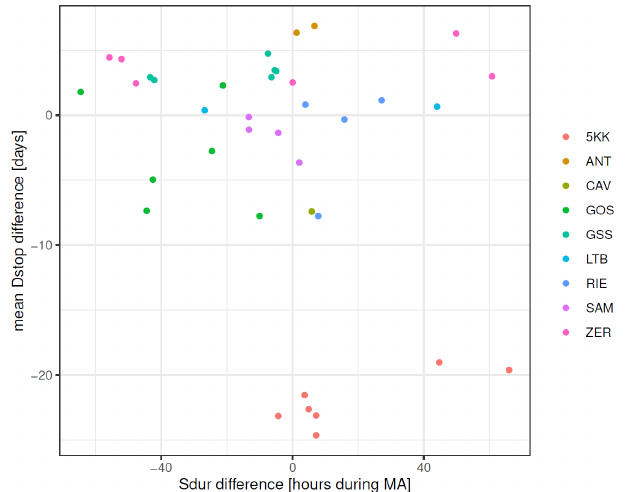
Figure 6. Relationship between differences in snow disappearance dates (Dend) and differences in potential sunshine durations (Sdur) for the months March and April (MA), calculated for a selection of station pairs with manually checked coordinates during different time